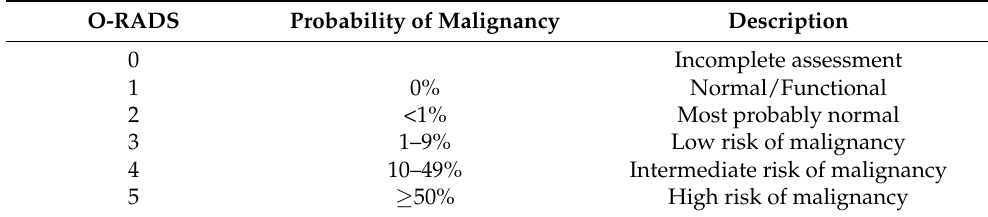
Table 3. Ovarian-Adnexal Reporting and Data System classification (O-RADS). O-RADS Probability of Malignancy Description